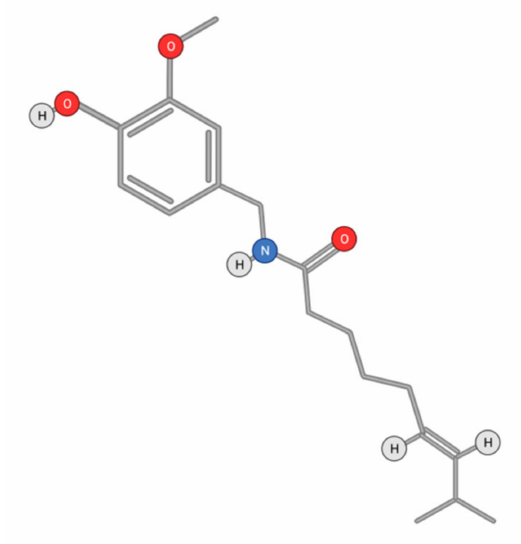
Figure 15. Chemical structure of